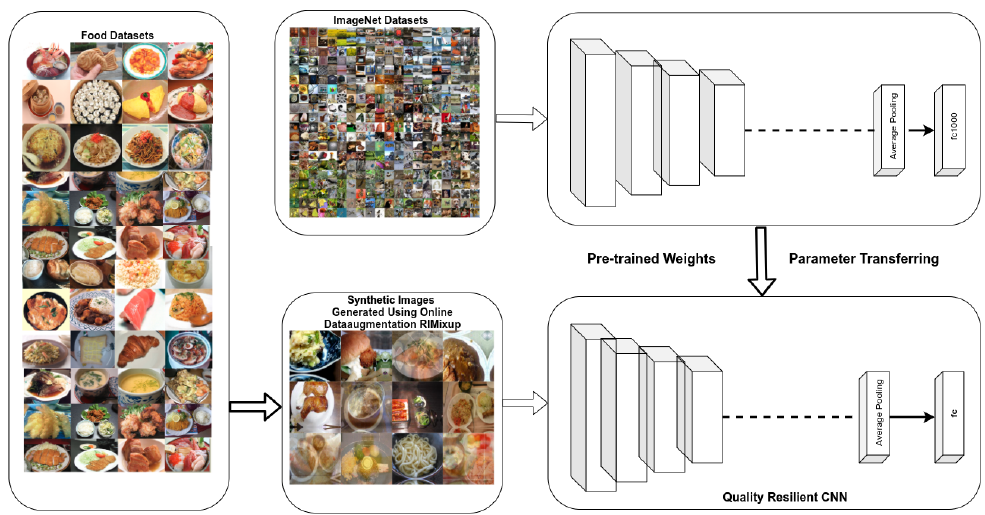
Figure 3. Quality resilient convolutional neural network (CNN) to extract visual